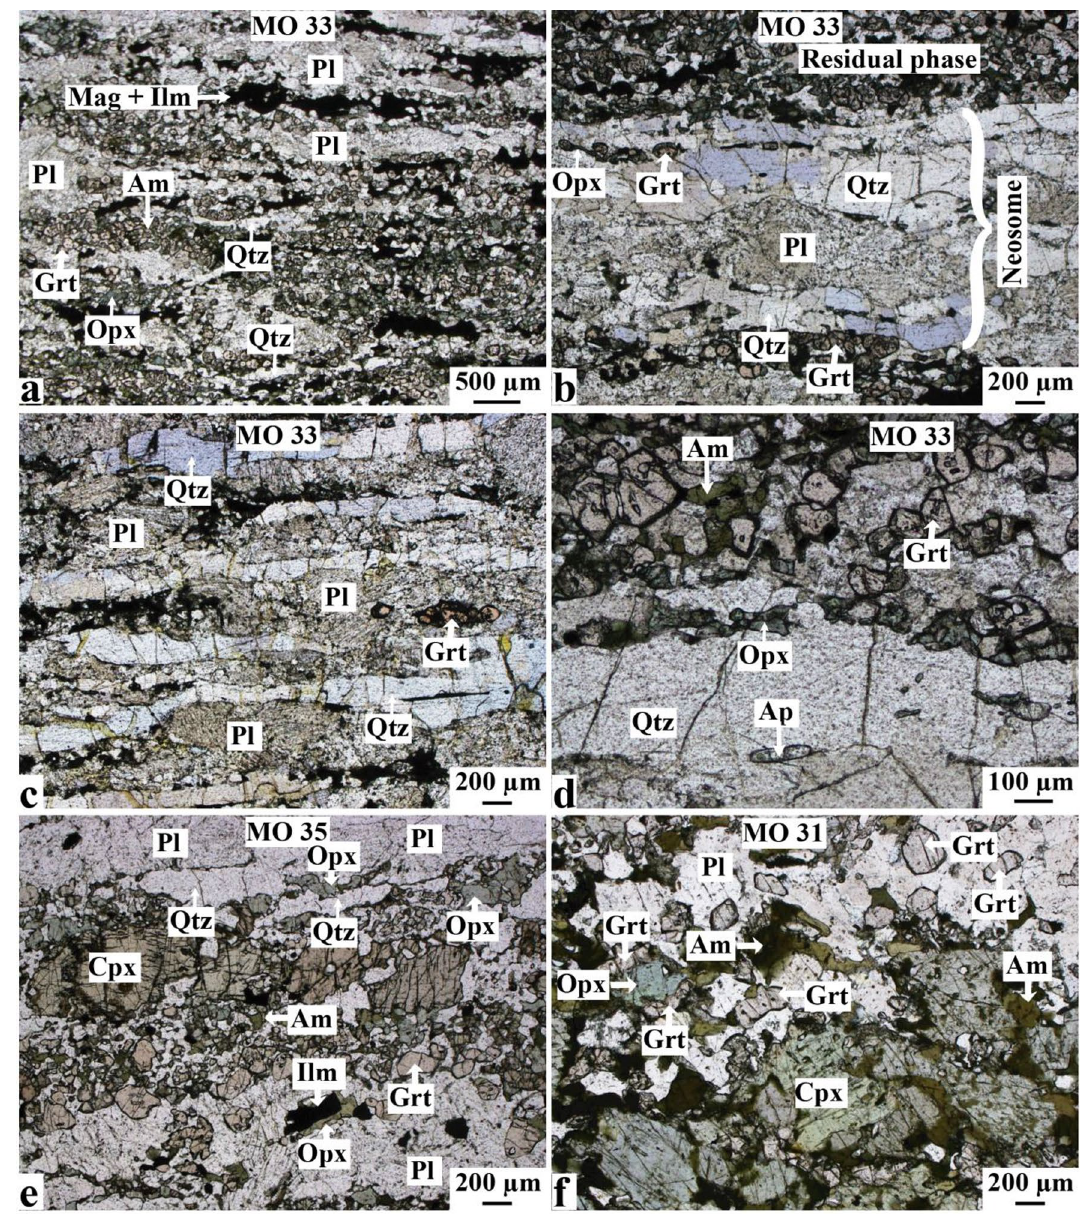
ilmenite (Ilm), f Green amphibole (Am) exsolution in clinopyrox- ene (Cpx), garnet (Grt) minerals droped in the leucosome band, g Green amphibole (Am) between garnet (Grt) and clionopyroxene (Cpx). Noted the presence of clinopyroxene (Cpx) and orthopyrox- ene (Opx) pseudomorphs and rutile (Ru), h Plagioclase(Pl), garnet (Grt), clinopyroxene (Cpx) and quartz (Qtz) assemblage. Noted both exsolusion and corona of green amphibole (Am) within clinopyroxene (Cpx), garnet (Grt) and clinopyroxene (Cpx) faces. i Partial corona of amphibole (Am) developed around (Cpx), j Equilibrium phase of amphibole (Am), garnet (Grt), clinopyroxene (Cpx), plagioclase (Pl) and quartz (Qtz), note also orthopyroxene (Opx)